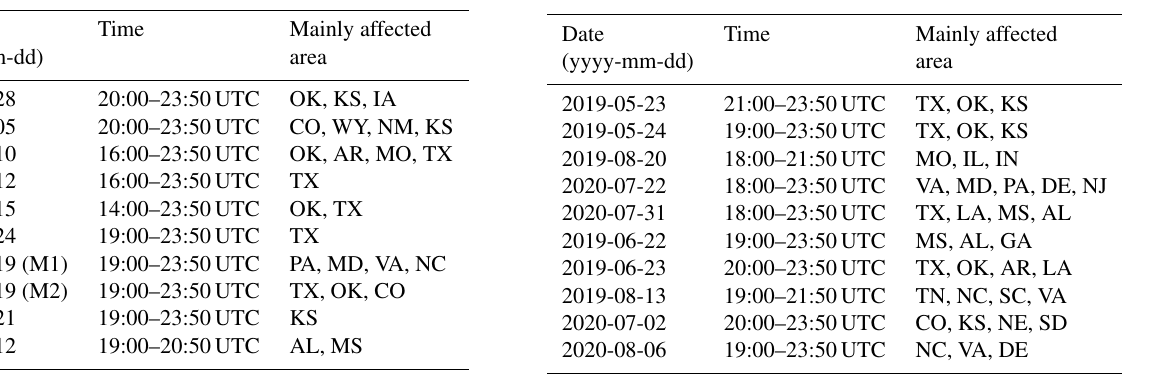
Table 2. A description of 10 convective cases used for validation (upper five) and testing (lower five)